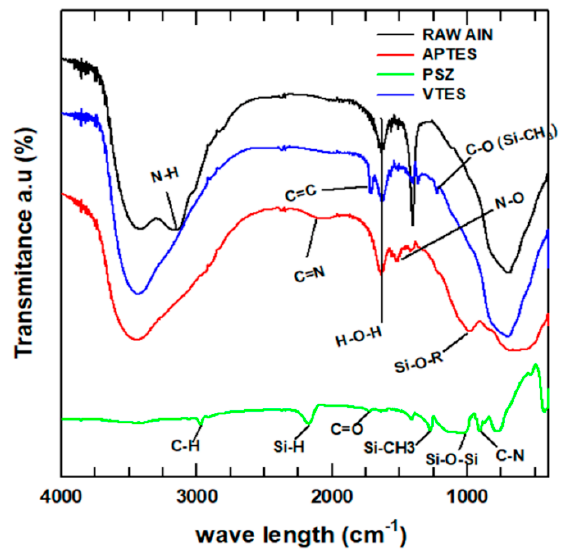
Figure 2. FTIR spectra of raw and treated AlN nanoparticles.